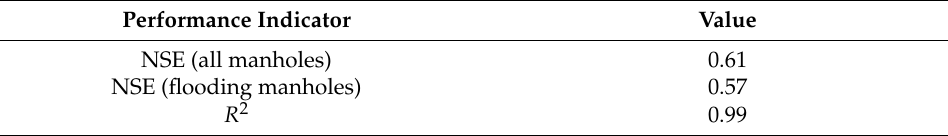
Figure 14. NSE values for each manhole in the case study area that experiences flooding from the historic data set (mean NSE = 0.57). NSE values have been calculated with the predicted flood volume time series by the LSTM network and sewer model. The NSE is calculated for each time series, and a mean is taken for the manholes. Dark grey manholes indicate locations where no flooding occurs. Table 3. Performance evaluation for the LSTM tested on historic